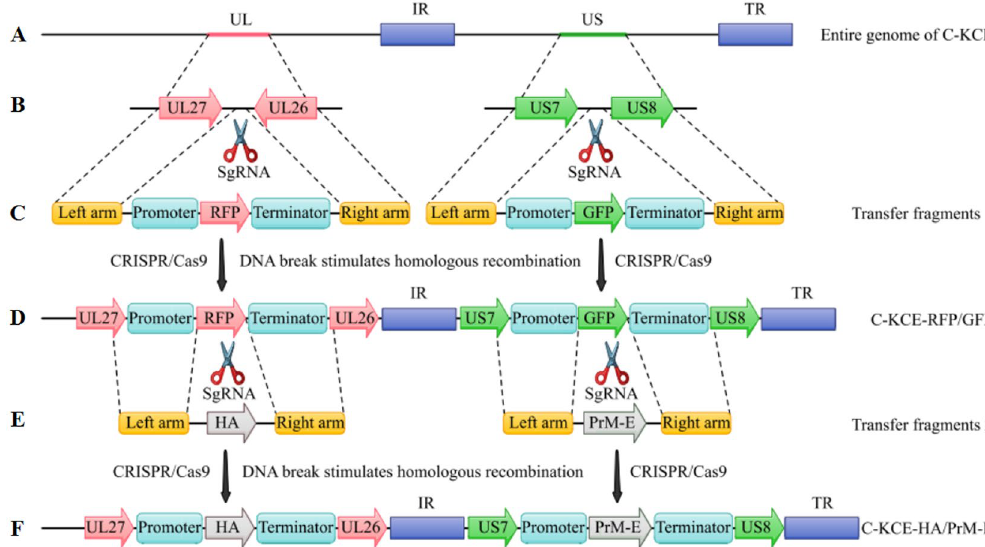
Figure 1. Schematic illustration of the novel candidate trivalent vaccine C-KCE-HA/PrM-E development. ( A ) Full-length of the attenuated commercial DEV vaccine strain (C-KCE). ( B ) Two portions of the genome C-KCE expanded to show the UL27, UL26, US7, and US8, and the gene junction regions are depicted. ( C ) The organization of transfer fragments Left arm-RFP-Right arm and Left arm-GFP-Right arm. ( D ) The recombinant C-KCE-RFP/GFP was generated using CRISPR/Cas9 system. ( E ) The organization of transfer fragments Left arm-HA-Right arm and Left arm-PrM-E-Right arm. ( F ) Following the CRISPR/Cas9 system mediated recombination, the recombinant C-KCE-HA/PrM-E was